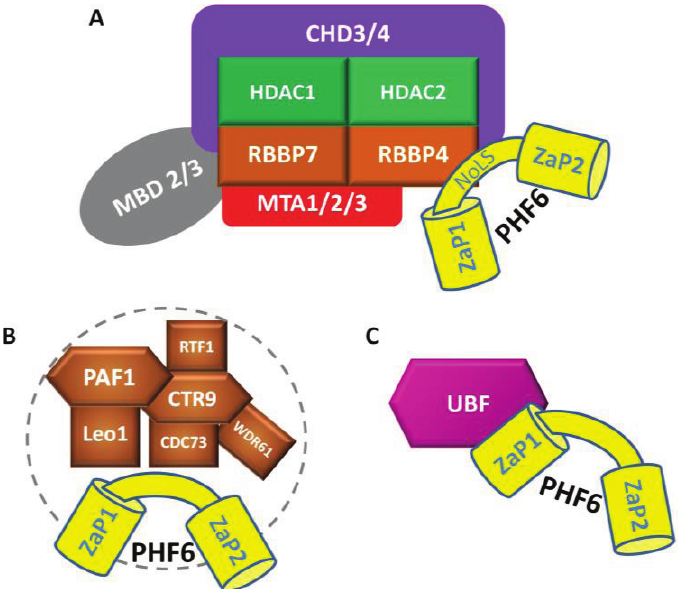
Figure 2. PHF6 interacting proteins. PHF6 associates with ( A ) the NuRD complex via